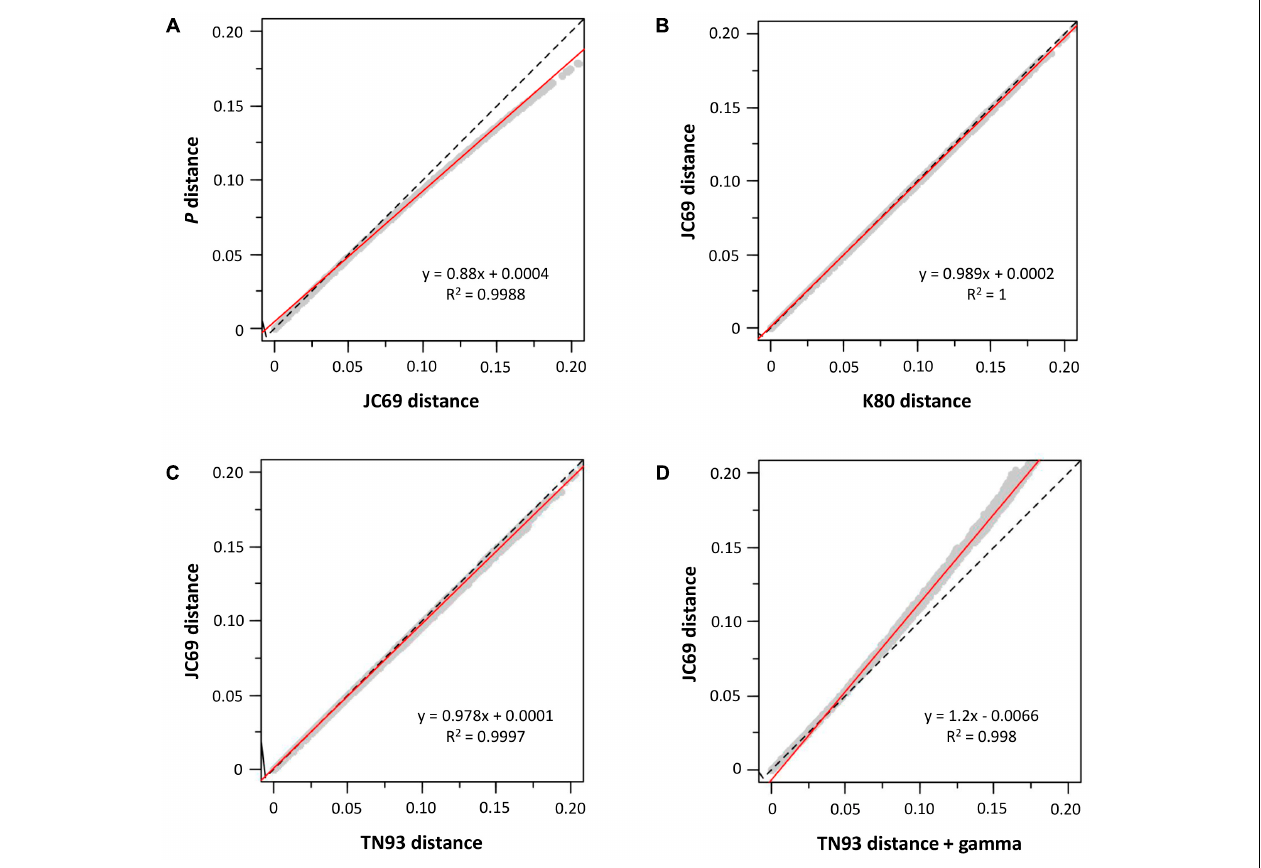
FIGURE 2 | Sequence analysis. Graphs (A–D) show the influence of different substitution models. The dashed line represents the equation y = x, and the red continuous line is the regression line whose equation appears in the corresponding graph.